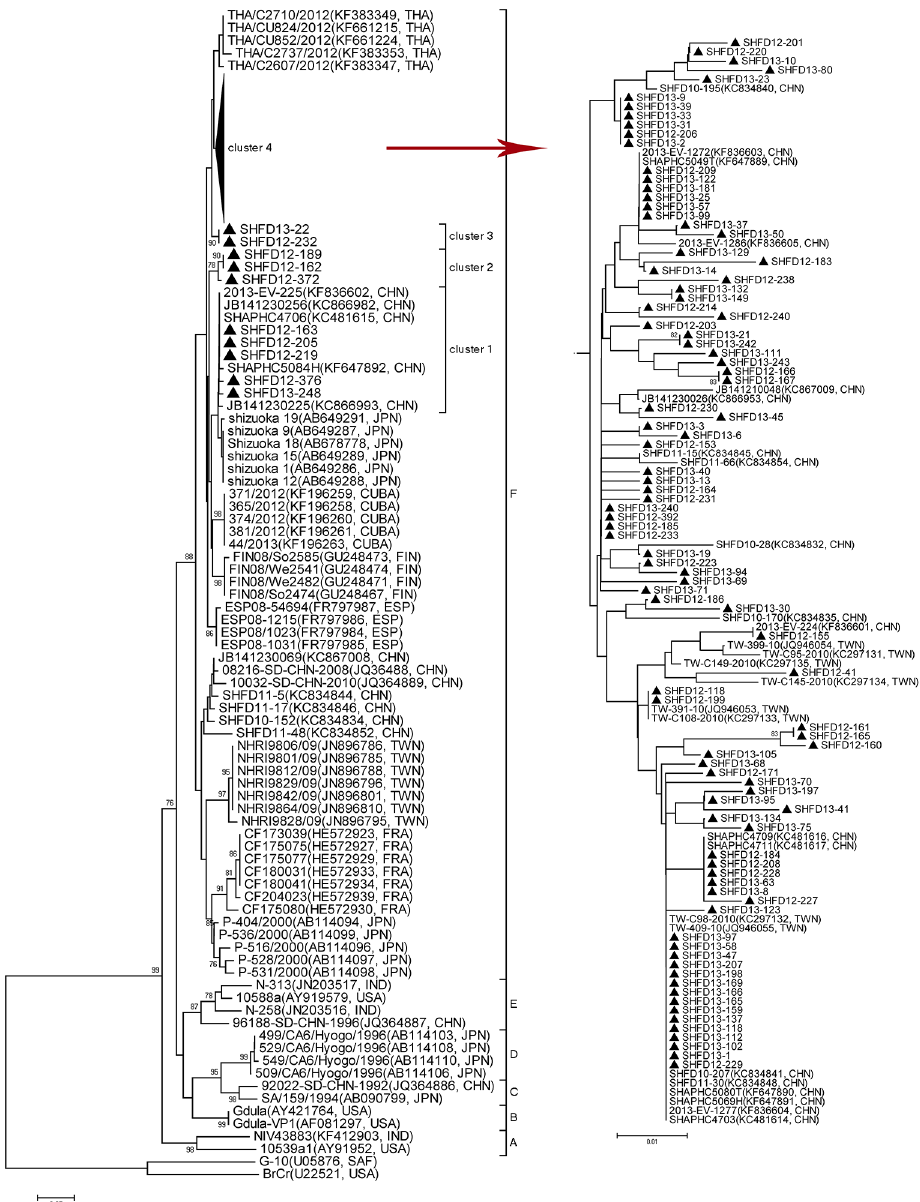
Fig 3. Phylogenetic analysis with the neighbor-joining method with a 1000-bootstrap re-sampling based on the alignment of the 368 nucleotide VP1 gene of 102 Shanghai CA6 strains. The strains labeled with ▲ were obtained in our